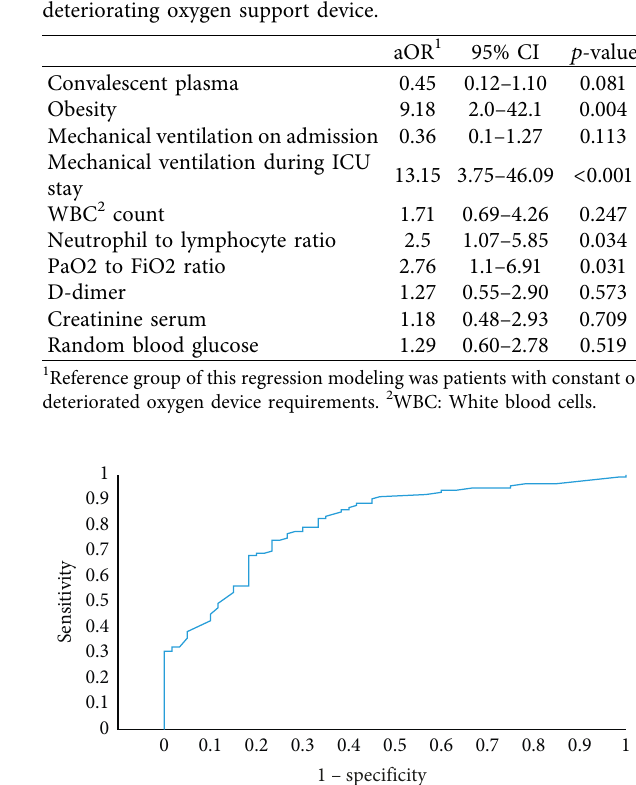
Figure 3: Receiver operating characteristics graph of constant and deteriorating oxygen support